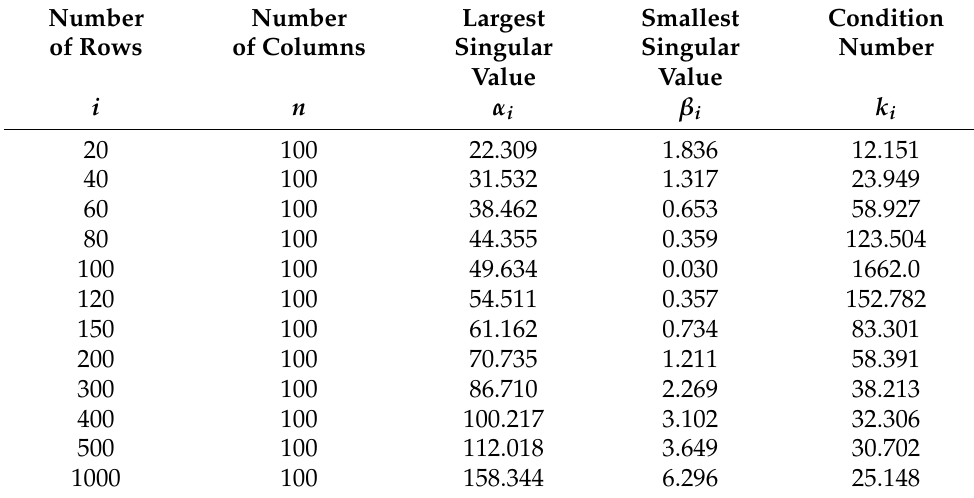
Table 6. The anomaly in nonnegative random matrix.